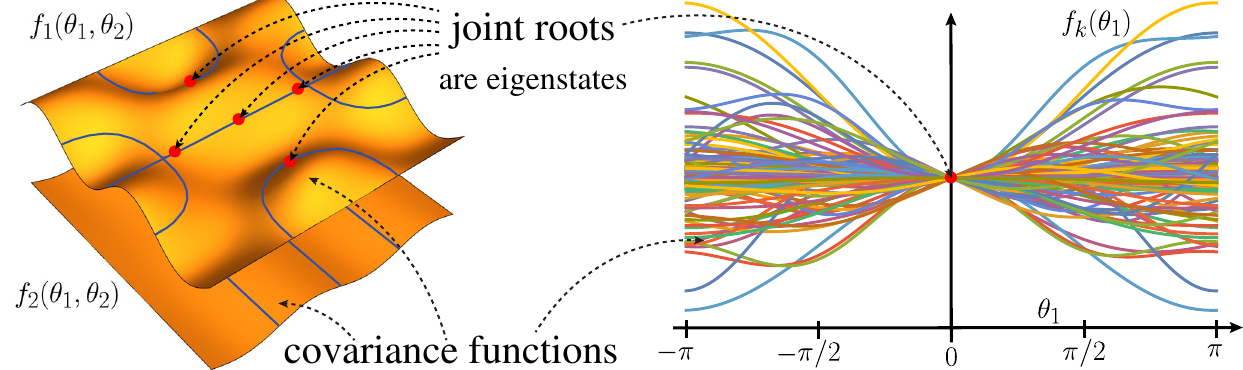
FIG. 1. Left: a toy example of a two-qubit problem whose eigenstates we aim to find by finding parameters of a variational quantum ≔ h O ; H i ψ between our problem Hamiltonian and between state j ψ ð θ 1 ; θ 2 Þi prepared by two parametrized gates. Covariances f k k observables O span classical surfaces (orange surfaces) and express uncertainty relations between those operators. Blue lines show k roots as regions in parameter space where these uncertainties (covariances) vanish; i.e., at roots θ ⋆ , the equation is satisfied f 1 ð θ ⋆ Þ ¼ 0 . Intersections of the lines in the above surface with those of the below surface (red dots) guarantee eigenstates of the problem Hamiltonian as joint roots f 1 ð θ Þ ¼ f 2 ð θ Þ ¼ 0 . Right: We use the extremely powerful classical shadow techniques to determine a very θ θ large number of these covariances f 1 Þ whose slices along the parameter 1 are shown in a practically relevant variational circuit (solid k ð lines). We initialize at θ 1 ≠ 0 and iteratively find the joint root at θ ⋆ 1 ¼ 0 (red dot): We use a Levenberg-Marquardt step whereby we linearize the covariances through computing a Jacobian and solve the resulting large, overdetermined linear system of